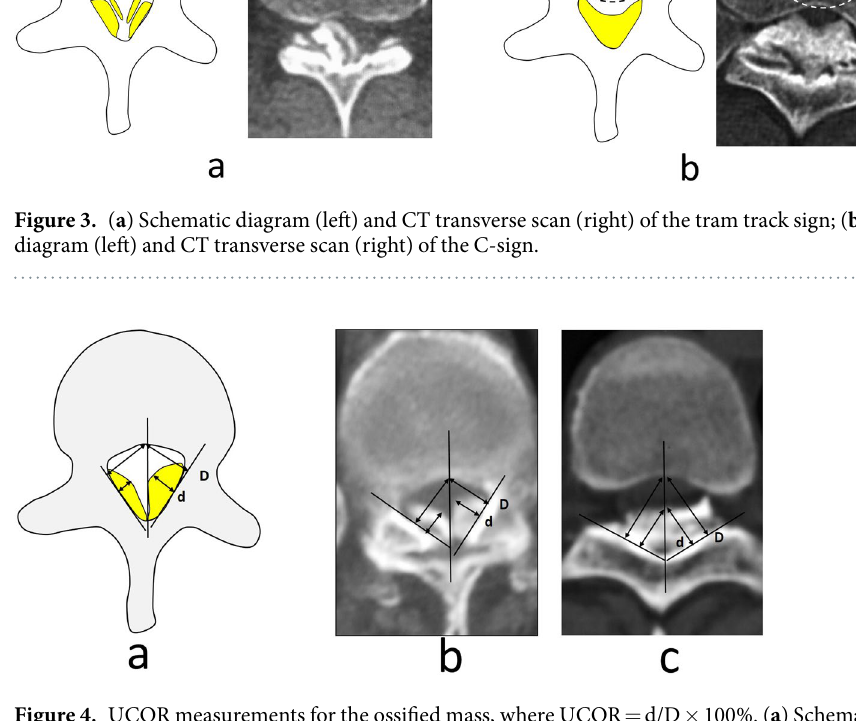
Figure 4. UCOR measurements for the ossified mass, where UCOR = d/D × 100%. ( a ) Schematic diagram of the measuring method. ( b ) Measurement on CT transverse scan through facet joint. ( c ) Measurement on CT transverse scan through vertebral